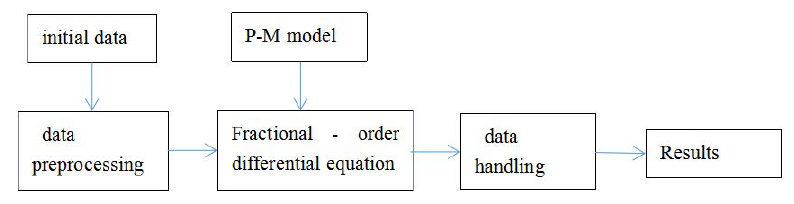
Fig. 2 Image information processing